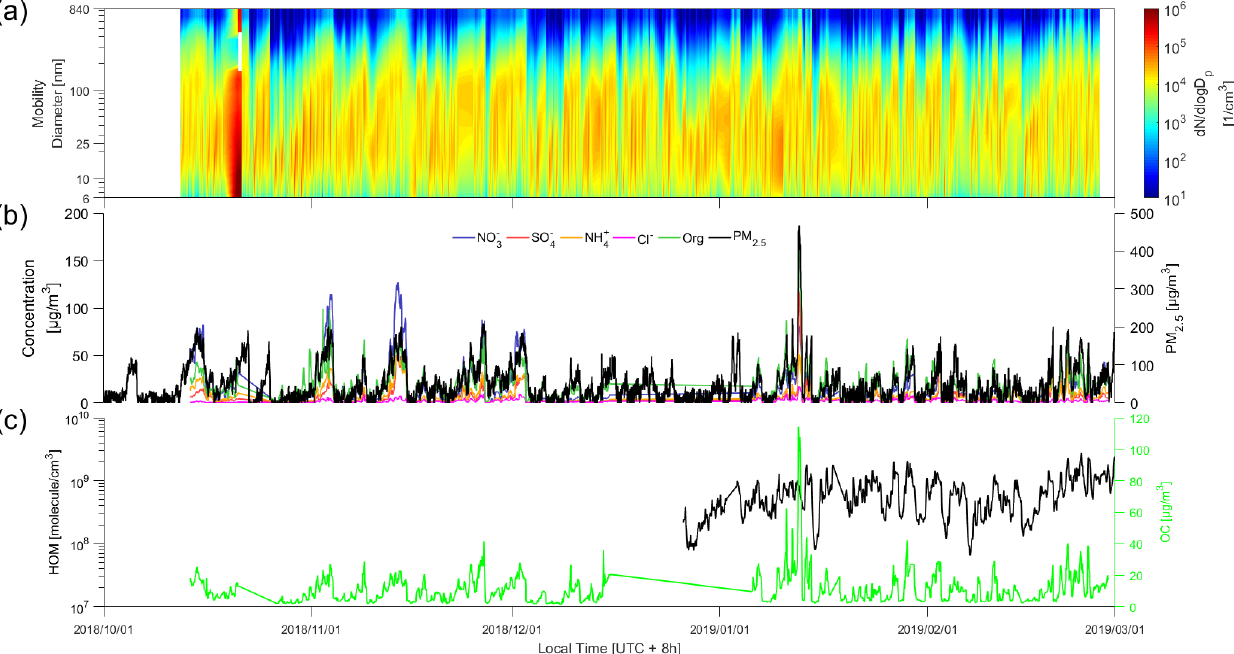
Figure 1. Time series of (a) particle number concentration distribution (PNSD) from 6 to 840nm and (b) chemical composition of NR_PM 2 . 5 and PM 2 . 5 mass concentrations. (c) The concentrations of organic carbon (OC) and highly oxygenated organic molecules (HOM).